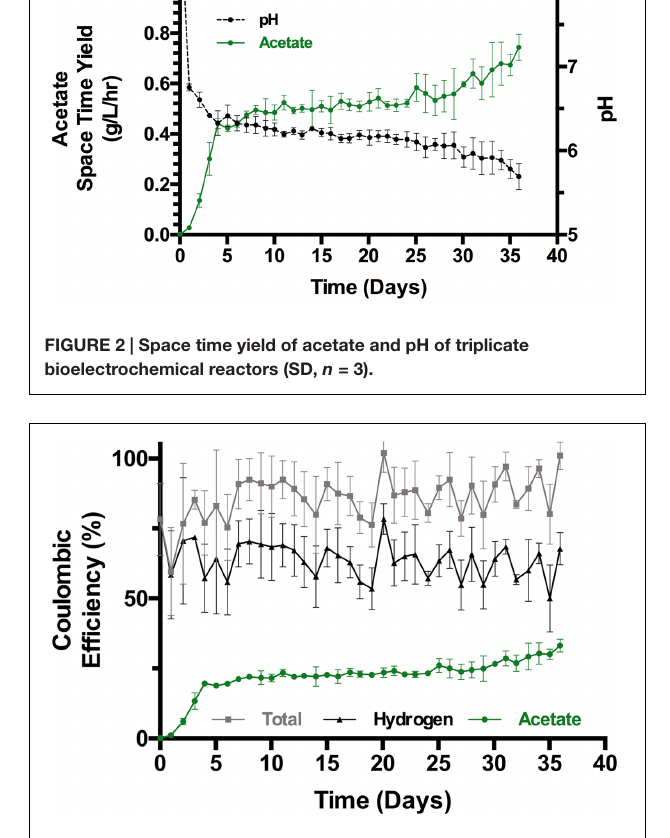
FIGURE 3 | Coulombic efficiency of triplicate bioelectrochemical reactors (SD, n =